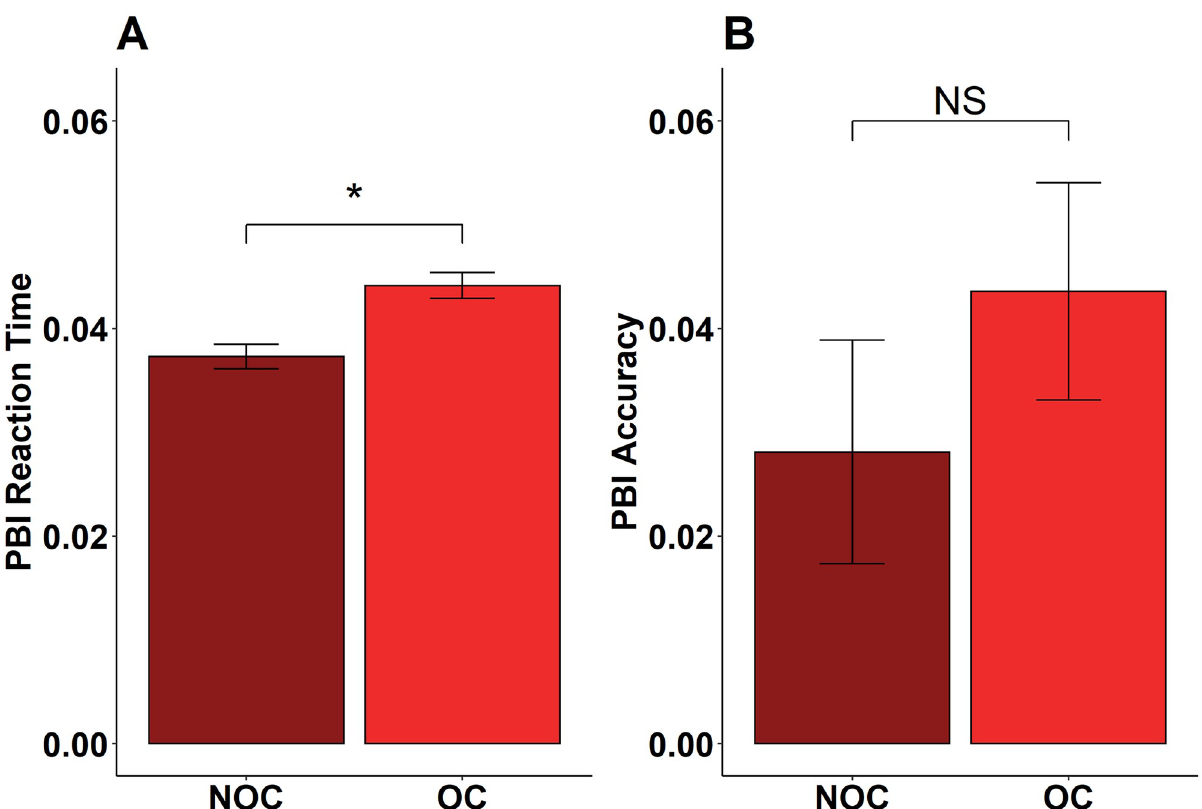
Fig 5. PBI reaction time depends on group. (A) NOC have significantly lower PBI reaction time than OC; (B) PBI accuracy is comparable between NOC and OC. Error bars refer to SEM, � p < 0.05, NS = not significant.